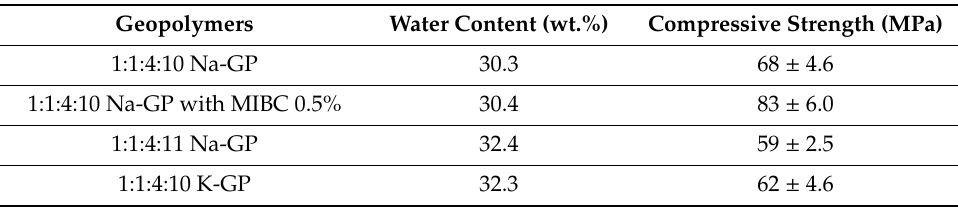
Table 3. The water content in each mixture, including the free water in the mixture proportions and the chemical water in the alkali hydroxides, is recalculated to encompass the water content in the polycarboxylates. A low MIBC dose is beneficial to both the flowability and strength development.